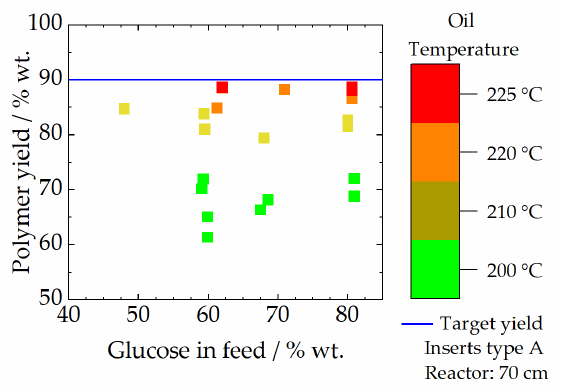
Figure 6. Polymer yield for different glucose concentrations%wt. in feed. Only samples for p out =2 ± 0.4 bar g in the 70 cm reactor are shown. The color scale refers to the oil set temperature.